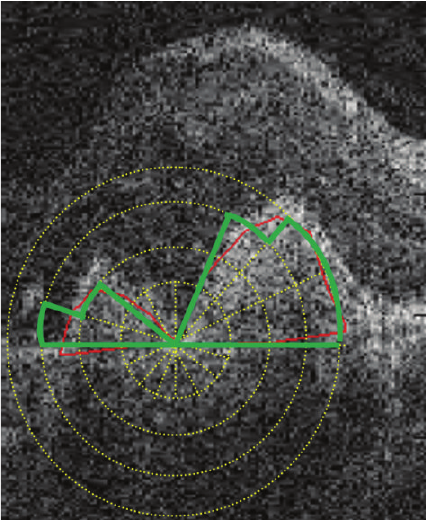
Figure 7: The red line shows the detected SEAD by an expert. The yellow circles show the isotropic windows with various radii. The greenlineillustratestheobtainedanisotropicbasedonLPA-ICIrule.